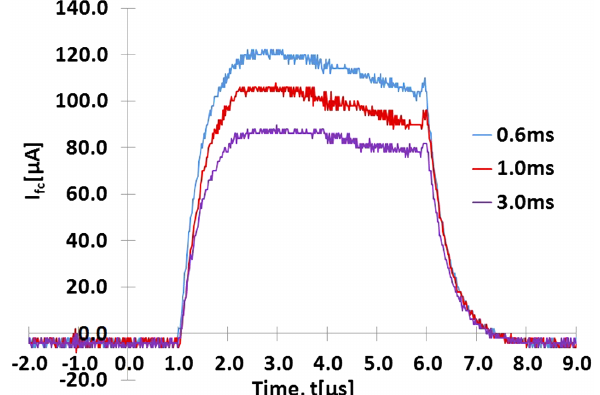
FIG. 12. Profiles of He 1 þ chopped beam pulses with a duration of 5 (cid:1) s , where chopping was performed at 0.6, 1.0, and 3.0 ms from the pulse head of the unchopped beam.